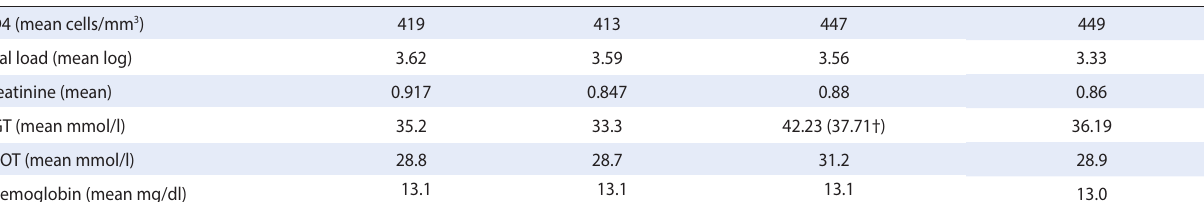
Note: From this table it is clear that there was no significant difference between the two arms at study initiation and study end. *The last available visit is the last visit for the patient before the study termination date that was not the screening visit and that had a valid measurement for the parameter. † One patient had a very high GGT value of 674. The value in parentheses shows the average when this outlier is removed.